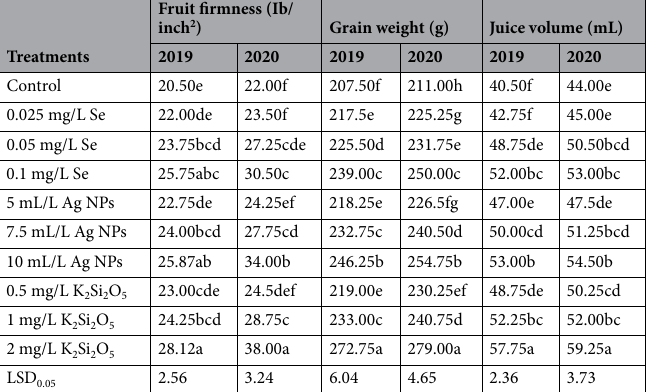
Table 6. Influence of the foliar spraying of Se, Ag NPS and K 2 Si 2 O 5 on fruit firmness, grain weight and juice volume in “Succary” pomegranate fruit during 2019 and 2020 seasons. Means not sharing the same letter(s) within each column are significantly different according to LSD at 0.05 level of significance.